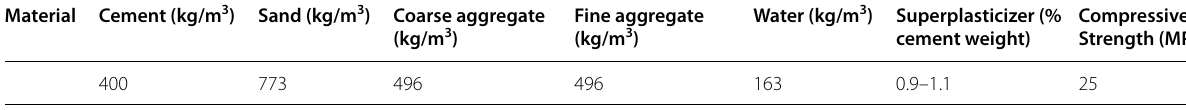
Table 1 Mix proportion of the C25 concrete